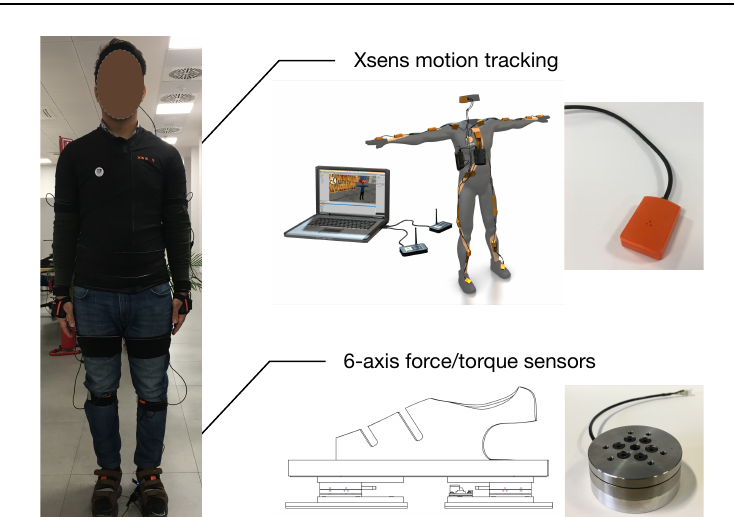
Figure 3. Subject equipped with the Xsens wearable motion tracking system and six-axis force/torque shoes.